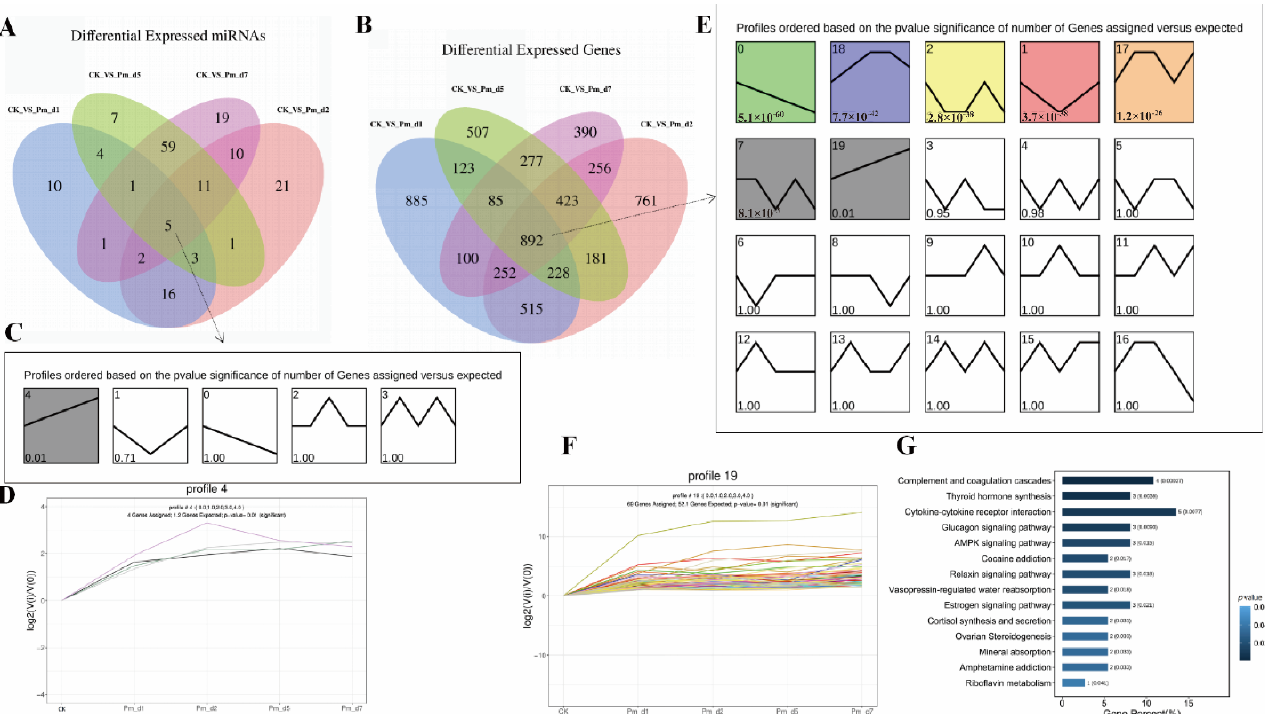
Figure 6. MiRNA and gene analysis by STEM clustering across the five time points. A total of 16 candidate profiles were obtained via STEM analysis. The five colored profiles are significant (FDR < 0.05). ( A , B ) The number of differentially expressed miRNAs and genes identified by each or combination of the different group compared with the CK group. ( C , E ) Common differentially expressed miRNAs and genes were assigned to a model profile that most closely matched its temporal expression profile. Statistically significant similar profiles form a cluster of profiles and are shown with the same color. The number in the top and bottom left-hand corner of each profile box is the profile ID and p -value. ( D , F ) The profile has a statistically significant number of miRNA and genes assigned based on a permutation test. ( G ) The genes in profile 19 significantly enriched the KEGG pathways ( p < 0.05). CK_vs_Pm_d1, CK_vs_Pm_d2, CK_vs_Pm_d5 and CK_vs_Pm_d7 indicate the goats infected with Pm compared to the CK group 1 day, 2 days, 5 days and 7 days after Pm infection, respectively.